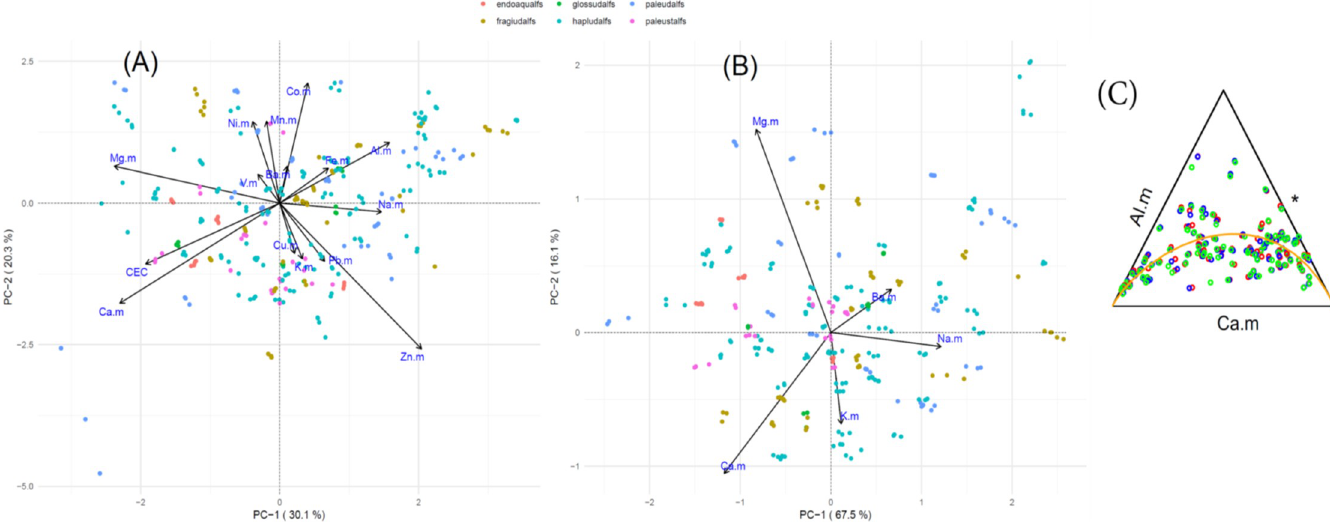
Fig 3. Statistical plots for the ME and CEC compositions (“.m” suffix refers to a constituent of the ME composition). (A) clr-transformed biplots for the ME composition, with samples grouped based on the Great Group designation. (B) clr-transformed biplots for the CEC composition, with samples grouped based on the Great Group designation. (C) Results of a marginal analysis of the CEC composition, where third component, “ � ”, represents the geometric mean of the Al and Ca parts, and the orange line representing the first principal component.